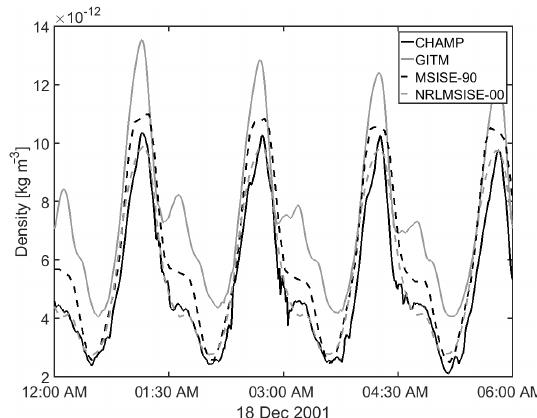
Figure 6. Logarithmic variation in the atmosphere density at 0 ◦ and 80 ◦ N latitude and 02:00LT as a function of altitude and adjusted solar flux (F10.7).